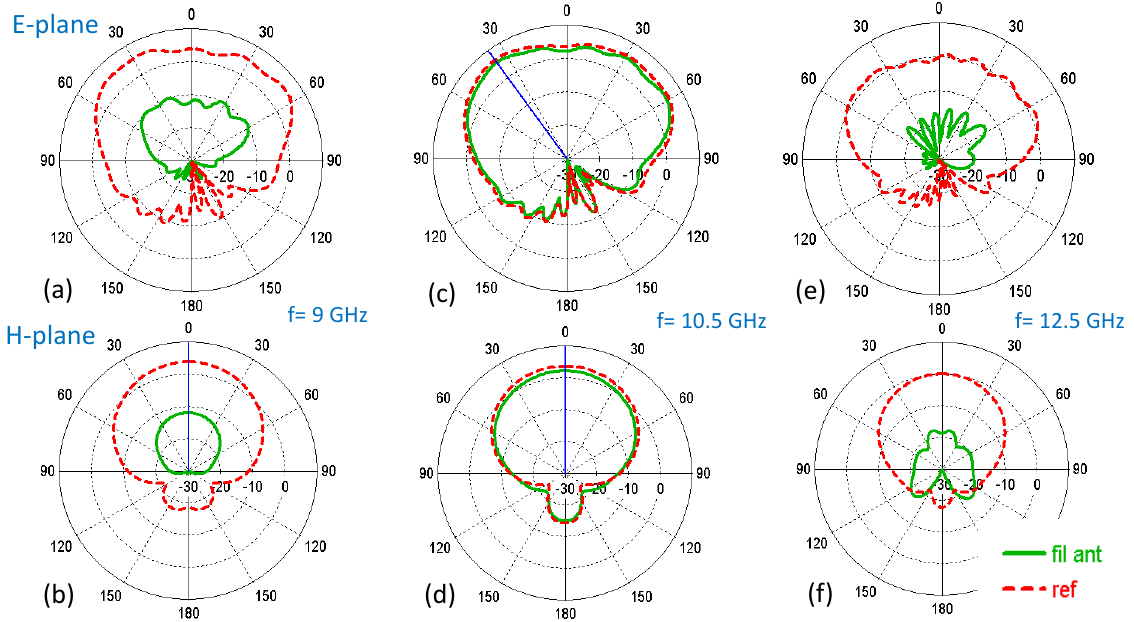
Figure 14. Simulated radiation patterns (realized gain) of the filtering antenna and the reference slot at different frequencies: ( a ) E-plane at f = 9 GHz ( b ) H-plane at f = 9 GHz ( c ) E-plane at f = 10.5 GHz ( d ) H-plane at f = 10.5 GHz ( e ) E-plane at f = 12.5 GHz and ( f ) H-plane at f = 12.5